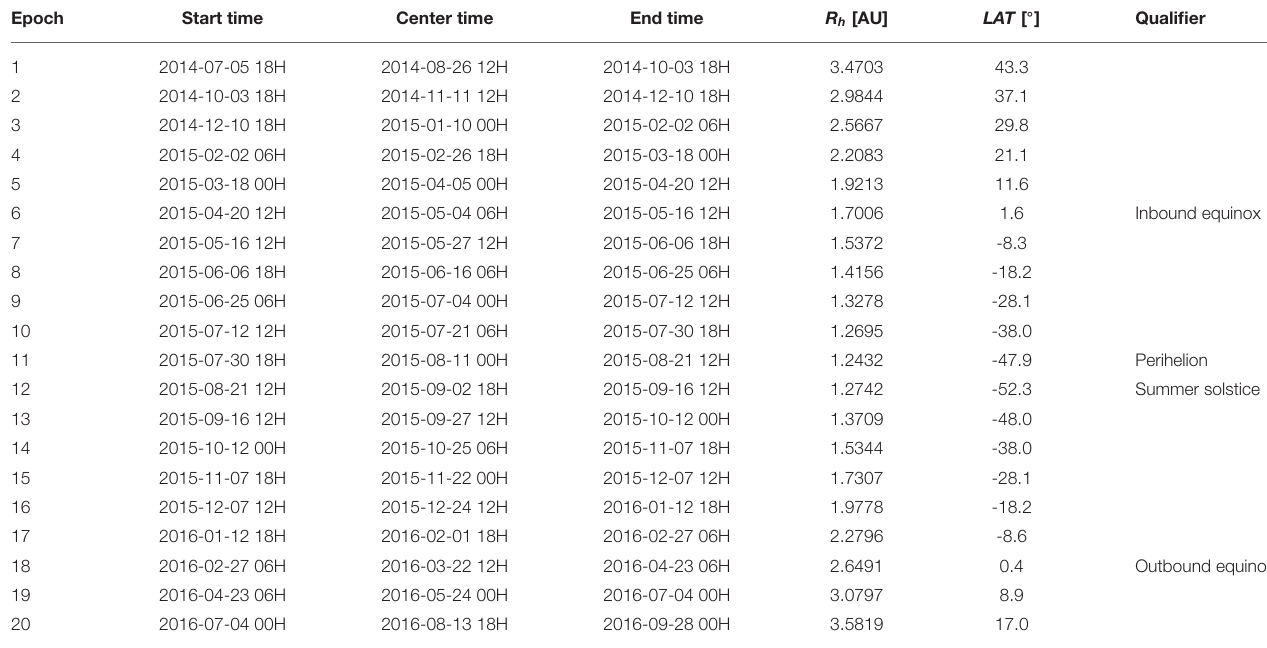
TABLE 1 | Start, center, and end time for each of the epochs as well as the heliocentric distance and sub-solar latitude of the center time of each epoch. Epoch